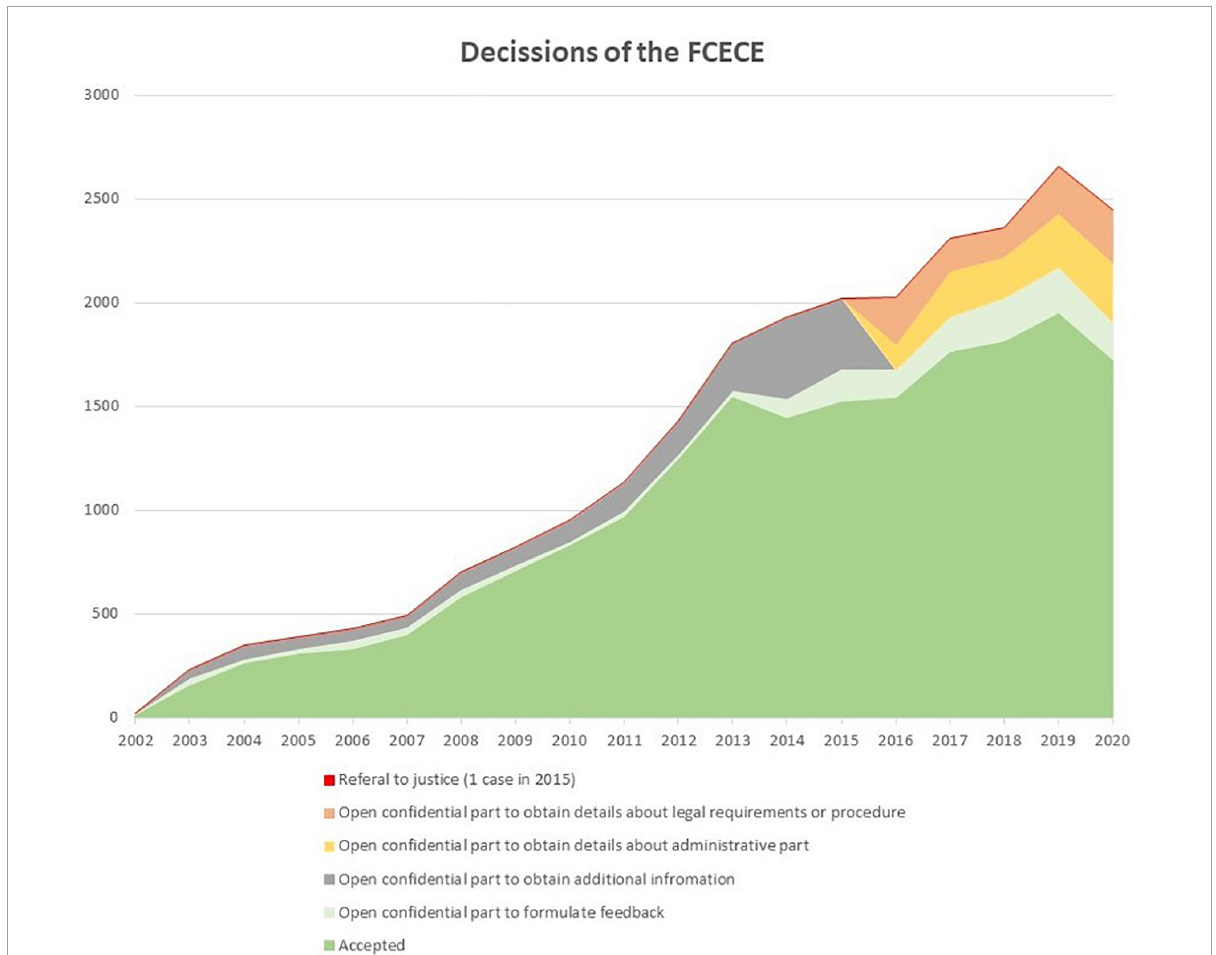
FIGURE4 Decisions of the Federal Commission (from the official reports of the FCECE). *Category of labels changed between 2015 and